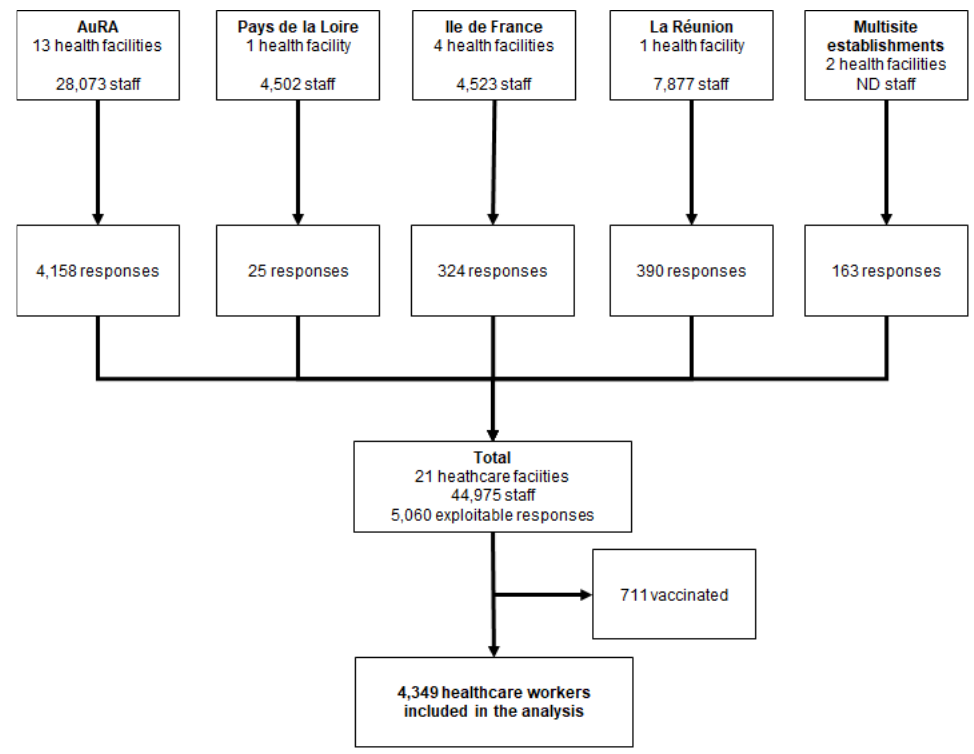
Figure 1. Study flow chart. ND—not-defined.